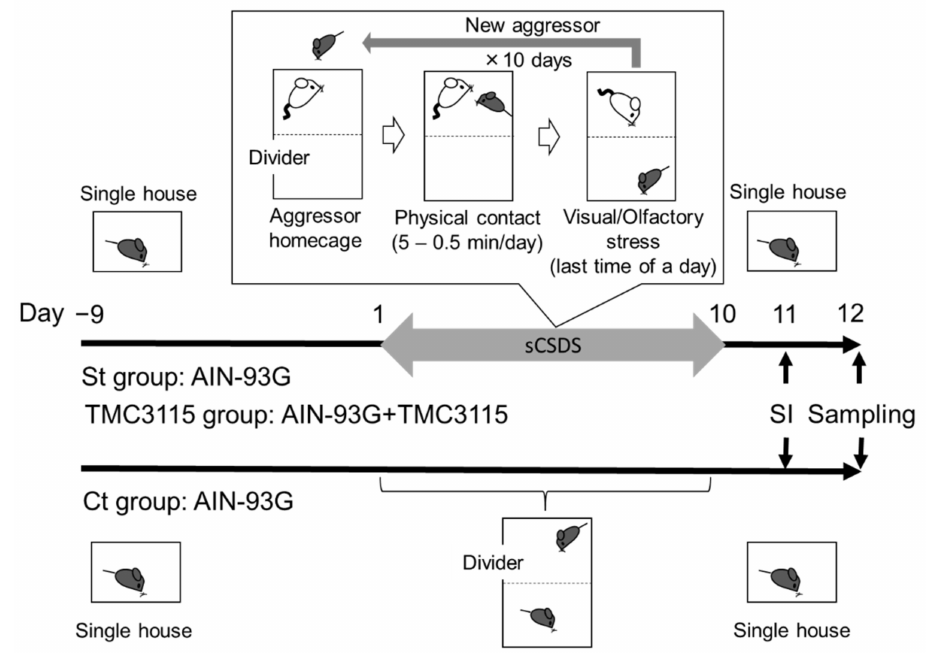
Figure 1. Experimental design. Mice in both the St and TMC3115 groups were subjected to the subchronic and mild social defeat stress (sCSDS) for 10 days. The behavior of all mice was observed by the social interaction (SI) test on Day